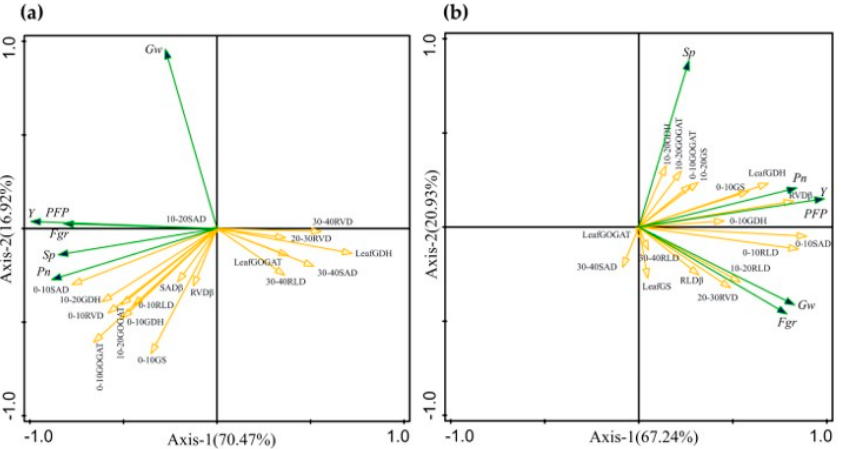
Figure 5. RDA analysis of root growth, physiological indexes and yield of rice. ( a ): T-43, ( b ): LX-3. 0–10 RLD: Root length density of 0–10 cm soil layer, 0–10 SAD: Surface area density of 0–10 cm soil layer, 0–10 RVD: Root volume density of 0–10 cm soil layer, 0–10 GS and 10–20 GS: Glutamine synthetase of 0–10 cm soil layer and 10–20 cm soil layer, 0–10 GOGAT and 10–20 GOGAT: Glutamate synthetase of 0–10 cm and 10–20 cm soil layer, 0–10 GDH: Glutamate dehydrogenase of 0–10 cm soil layer; RLD β :Root length density β value, RVD β :Root volume density β value; Pn: Panicle numbers, Sp: Spikelet per panicle, Fgr: Filled grain rate, GW: 1000-Grain weight, Y:Yield, PFP: Nitrogen partial factor